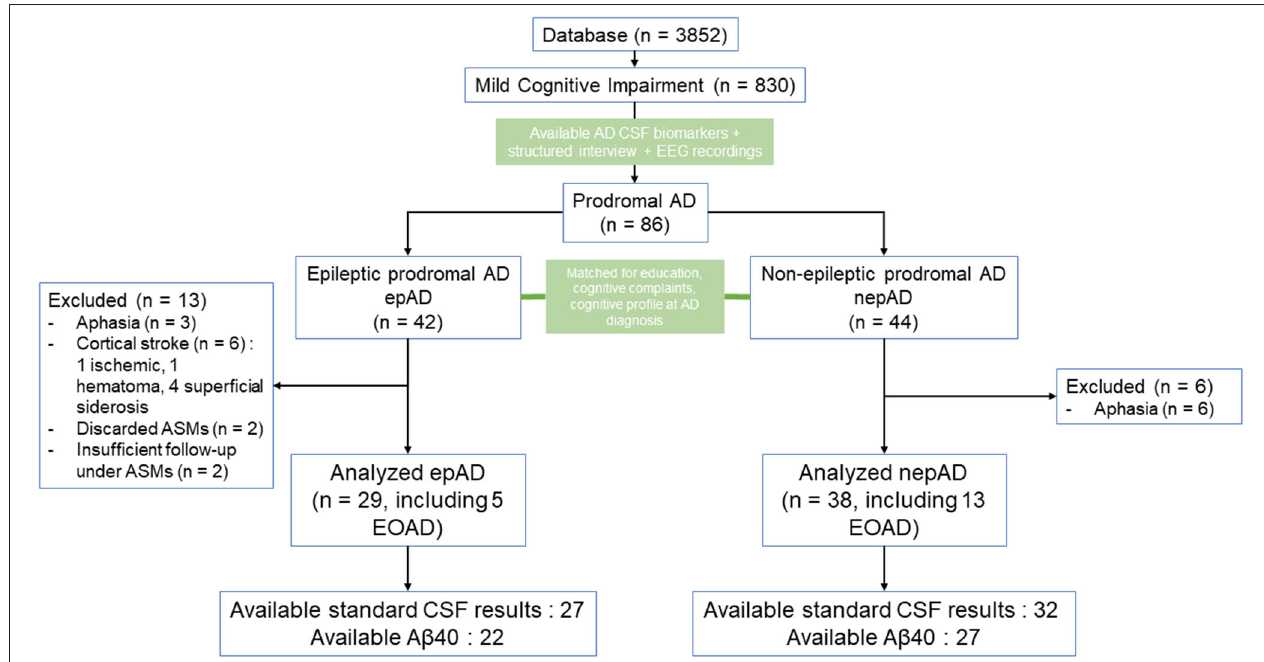
FIGURE 1 | Study flow chart. ASMs, antiseizure medications; CSF, cerebrospinal fluid; EOAD, early onset Alzheimer’s disease; LOAD, late onset Alzheimer’s